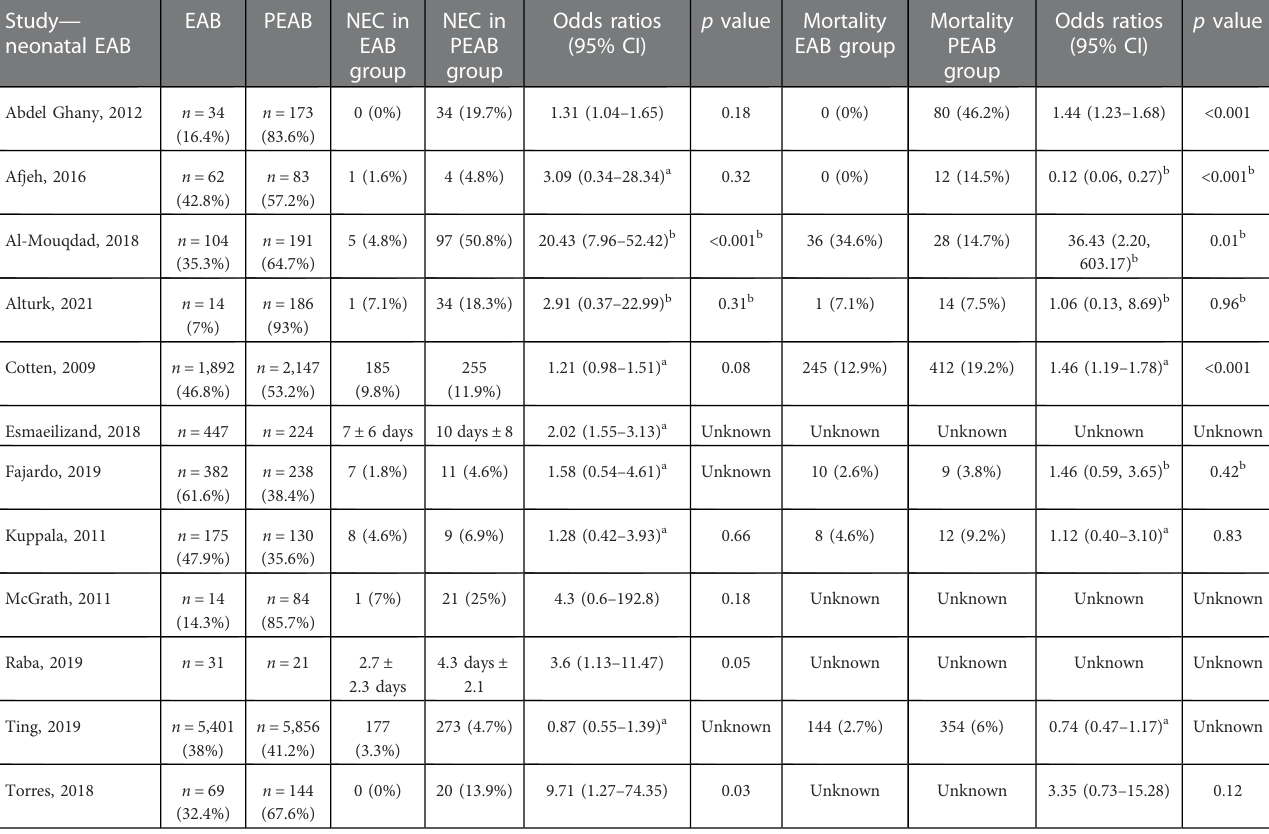
TABLE 4 Empirical antibiotics use compared with prolonged empirical antibiotics use.